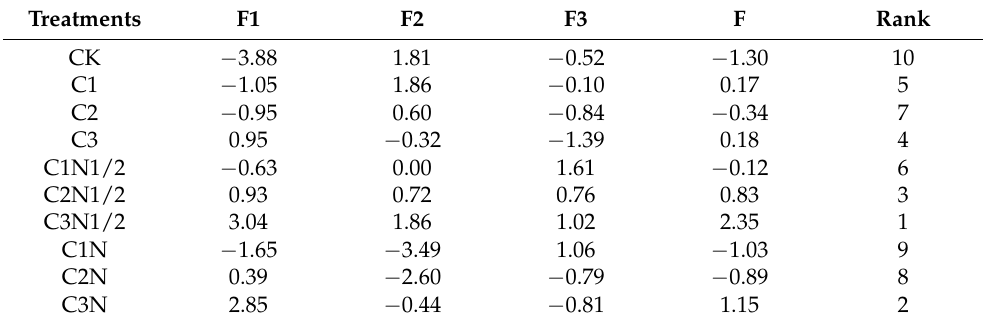
Table 5. Principal component evaluation value and comprehensive evaluation